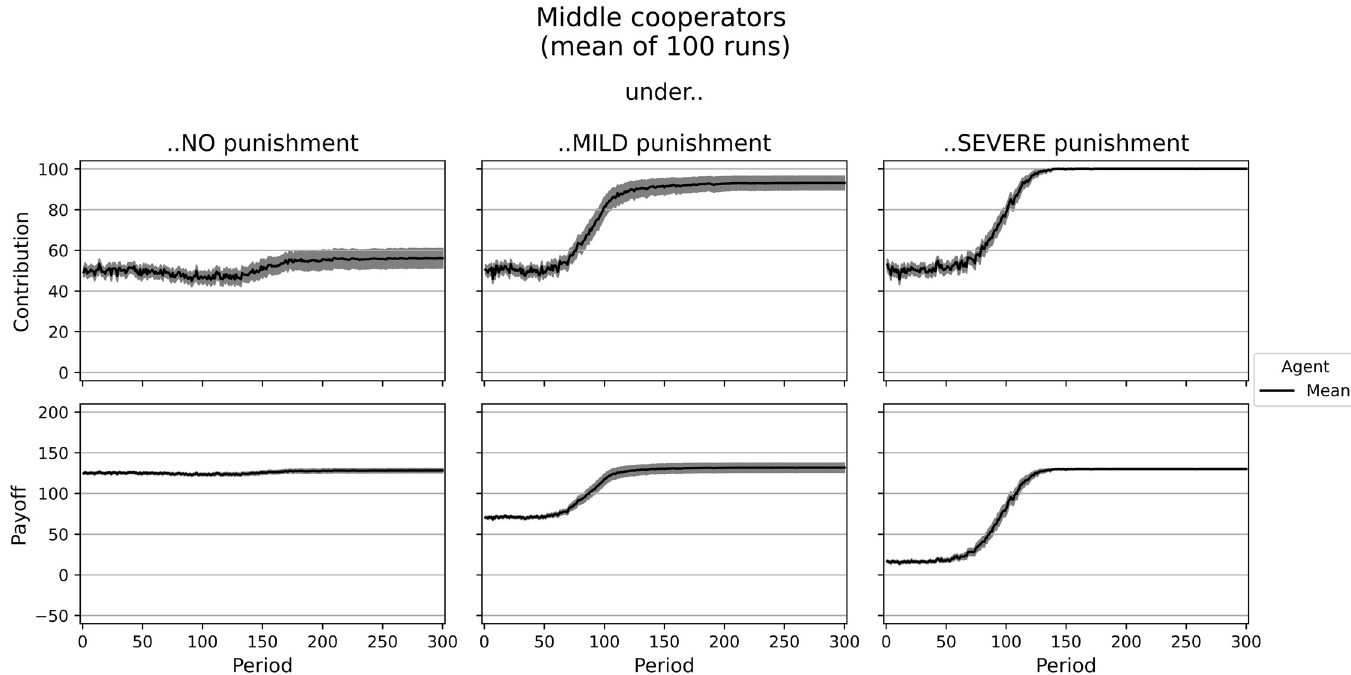
Fig 4. Dynamics of contributions and payoffs of middle cooperators under no, mild, and severe punishment. Arithmetic mean of 100 simulation runs. In gray: confidence interval (95%) around the mean.